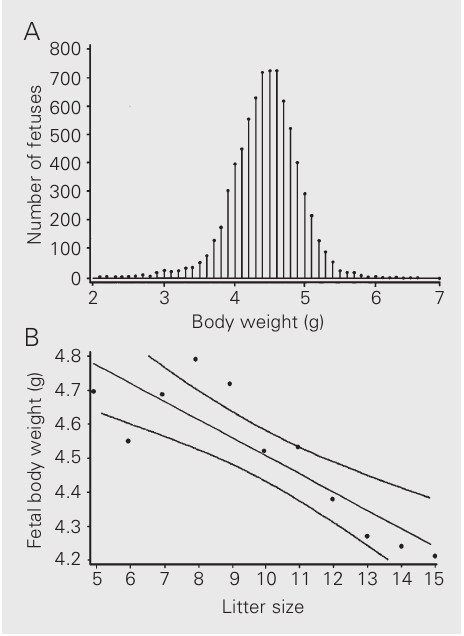
Figure 1. Fetal body weight and litter size. Panel A shows the frequency distribution of body weights (g) of 7594 fetuses (469 litters) examined in the present study. Panel B shows the linear regression (r = -0.99) and 95% confidence limits of mean fetal body weights (g) plotted against litter sizes. All fetuses were from untreated Wistar rats and were obtained by cesarean sec- tion on pregnancy day